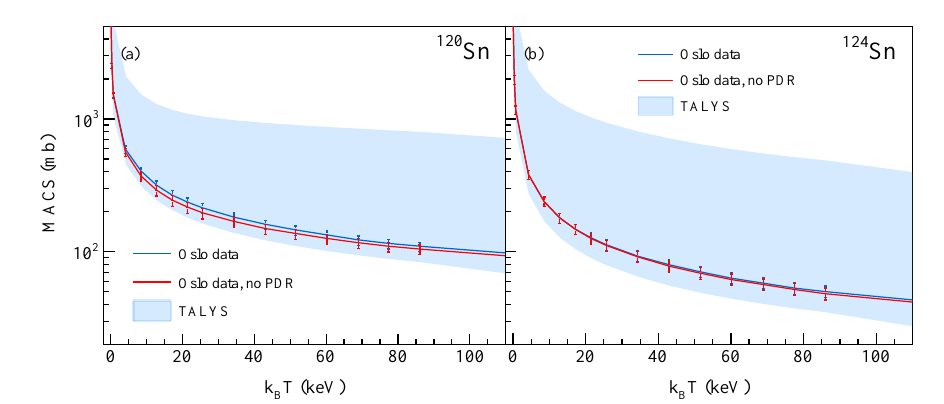
Figure 3. The MACS of 119 , 123 Sn( n ,γ ) 120 , 124 Sn reactions obtained with and without the PDR part of the total E 1 response compared with the TALYS span of cross